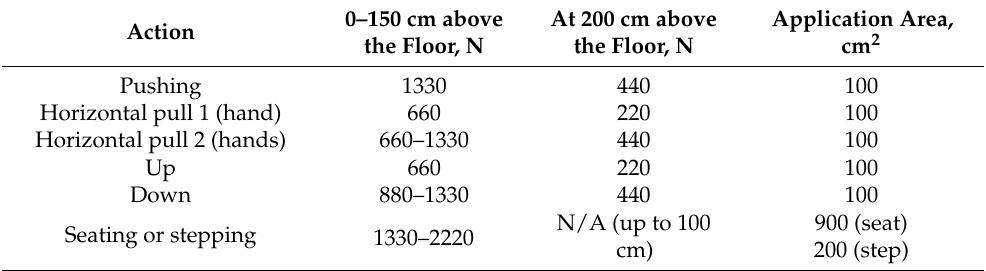
Table 1. General concentrated loads [11].